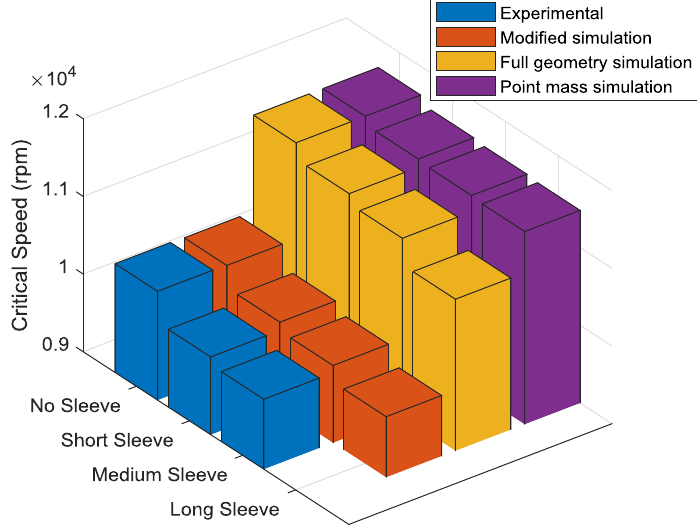
Figure 13. Critical speeds for all modelling approaches and experimental.